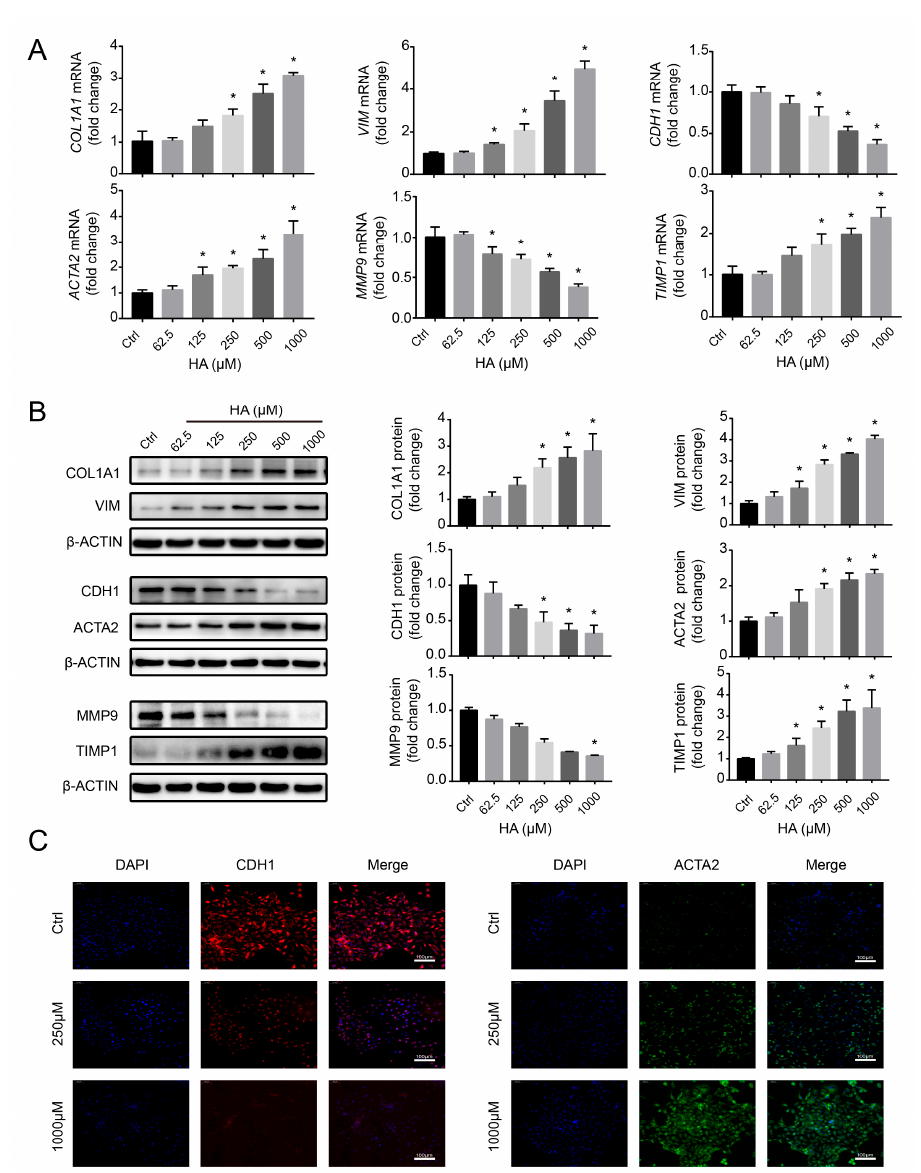
Figure 1. E ff ects of hippuric acid (HA) on fibrotic gene expression in HK-2 cells. ( A ) Relative mRNA and ( B ) protein expression levels of collagen-I (COL1A1), vimentin (VIM), E-cadherin (CDH1), alpha-smooth muscle actin (ACTA2), matrix metalloproteinase-9 (MMP9), and tissue inhibitor of metalloproteinases-1 (TIMP1) after treatment with 0–1000 µ M HA. Quantification was performed by densitometry. ( C ) Immunofluorescence staining for CDH1 (red) and ACTA2 (green) after treatment with 250 and 1000 µ M HA. Nuclei (blue) were stained with DAPI. Bar = 100 µ m. Data are presented as the mean ± standard deviation. * p < 0.05 vs. control (Ctrl) cells. Experiments were repeated three to four times.